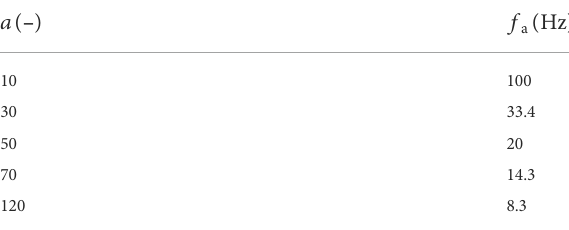
TABLE 1 Pseudofrequencies for the scales a (cid:2) { 10 , 30 , 50 , 70 , 120 } , central frequency